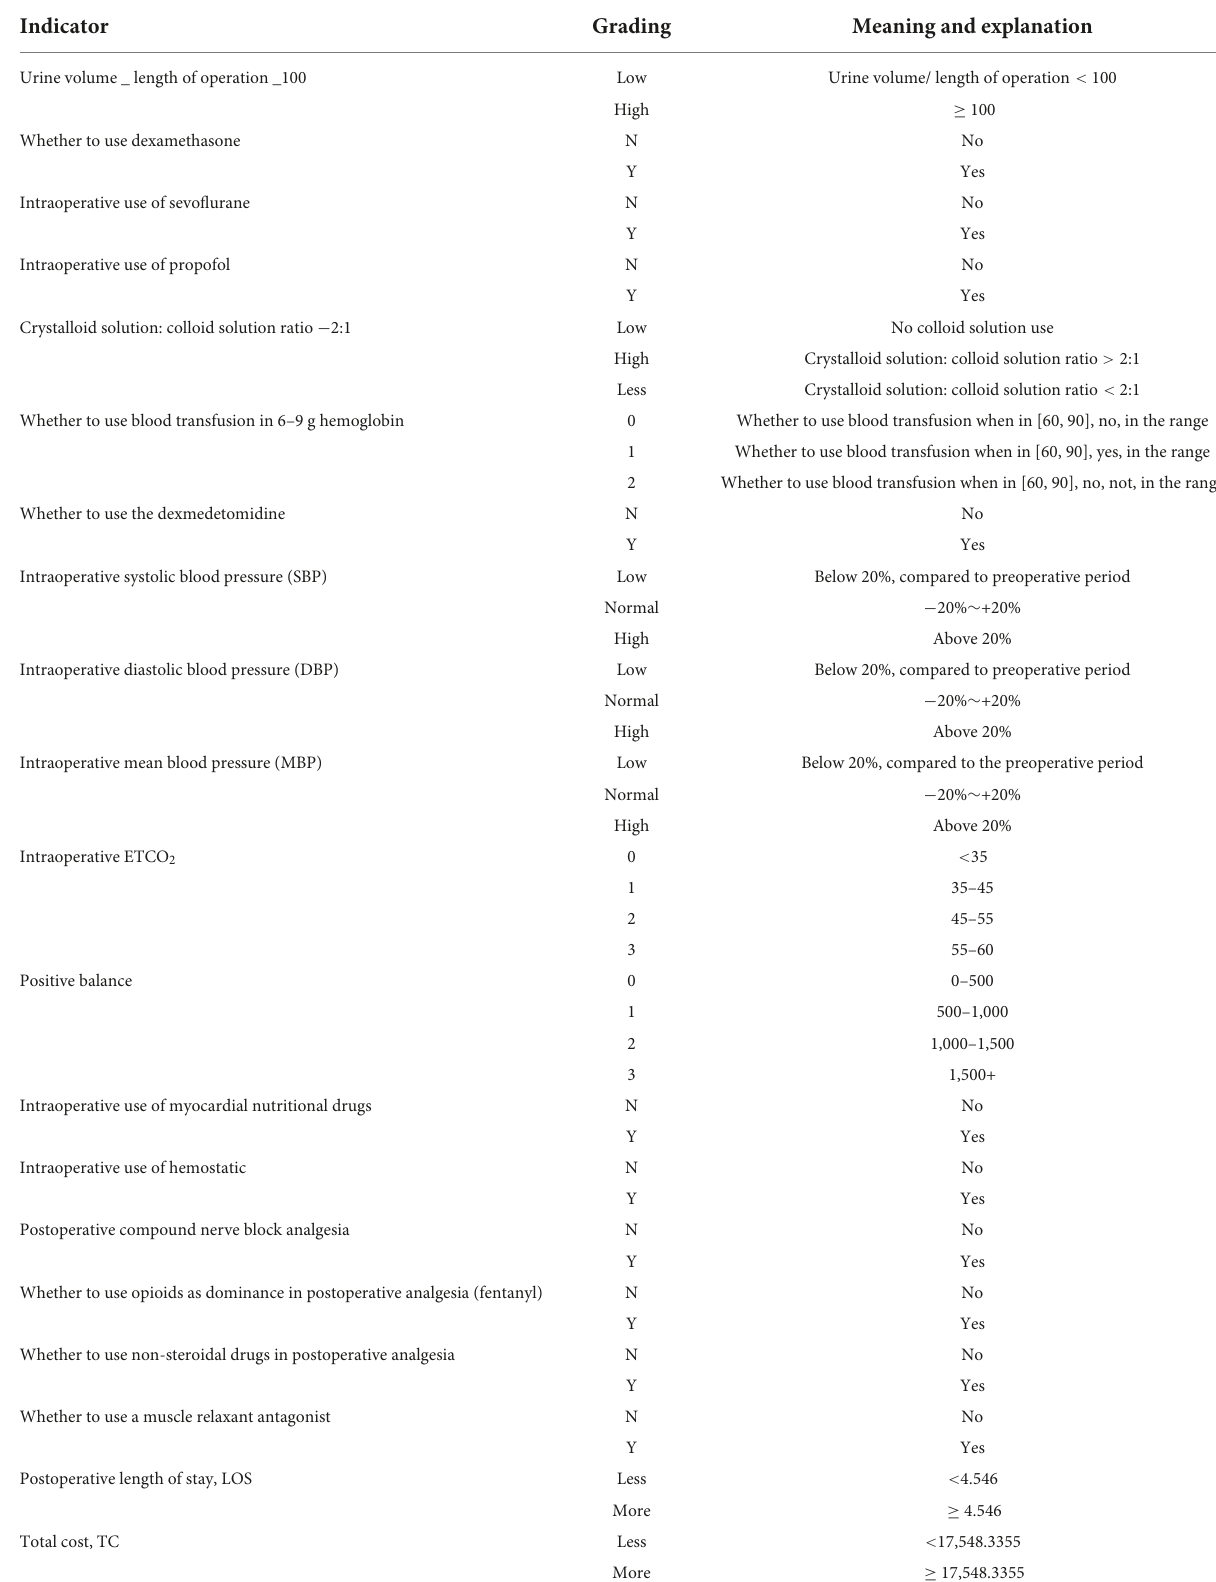
TABLE 1 The meaning and explanation of the value of each